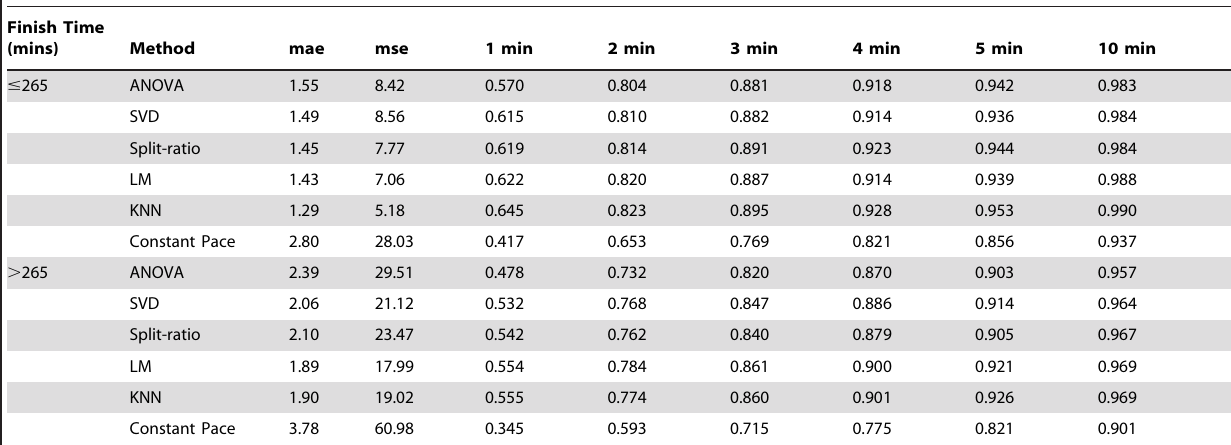
Table 5. Results by finishing